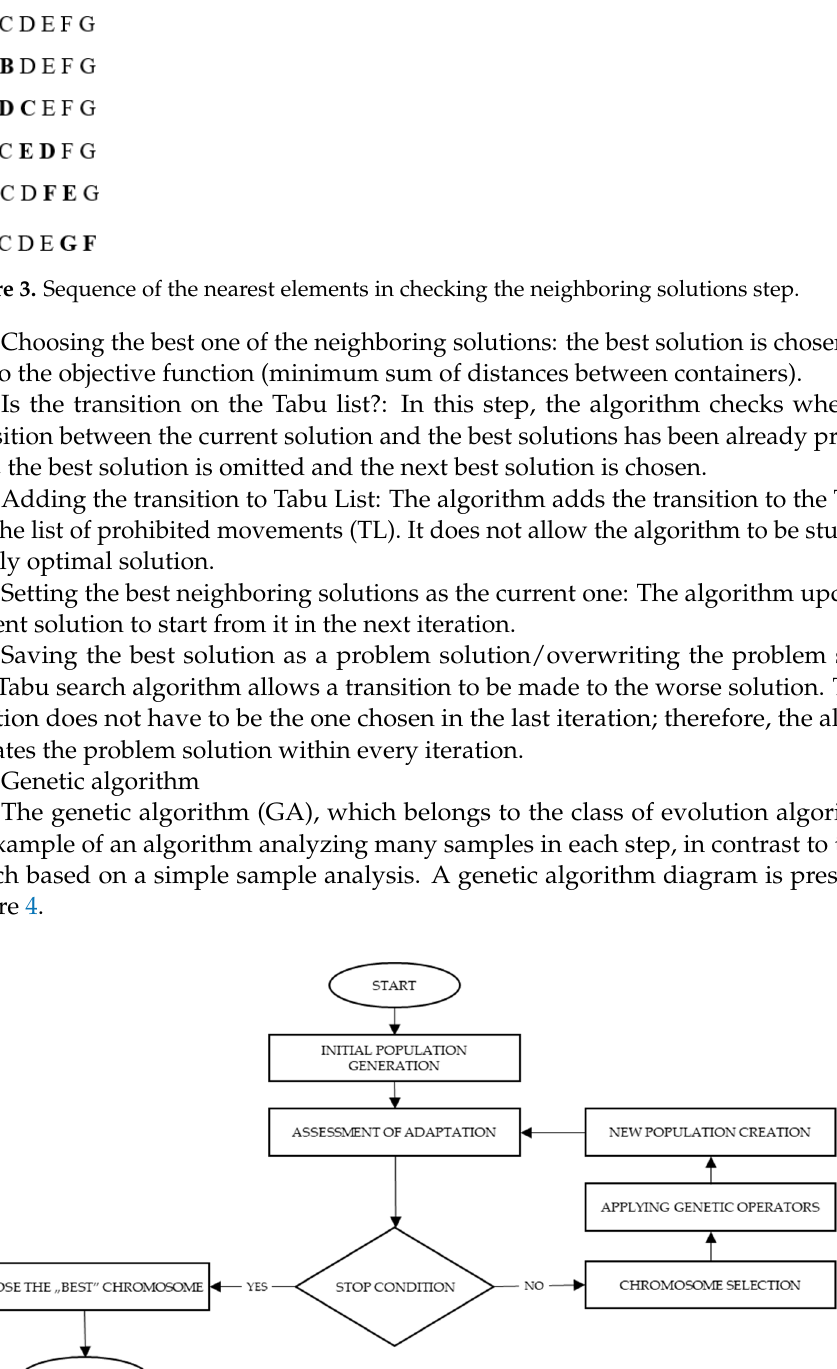
Figure 3. Sequence of the nearest elements in checking the neighboring solutions step.